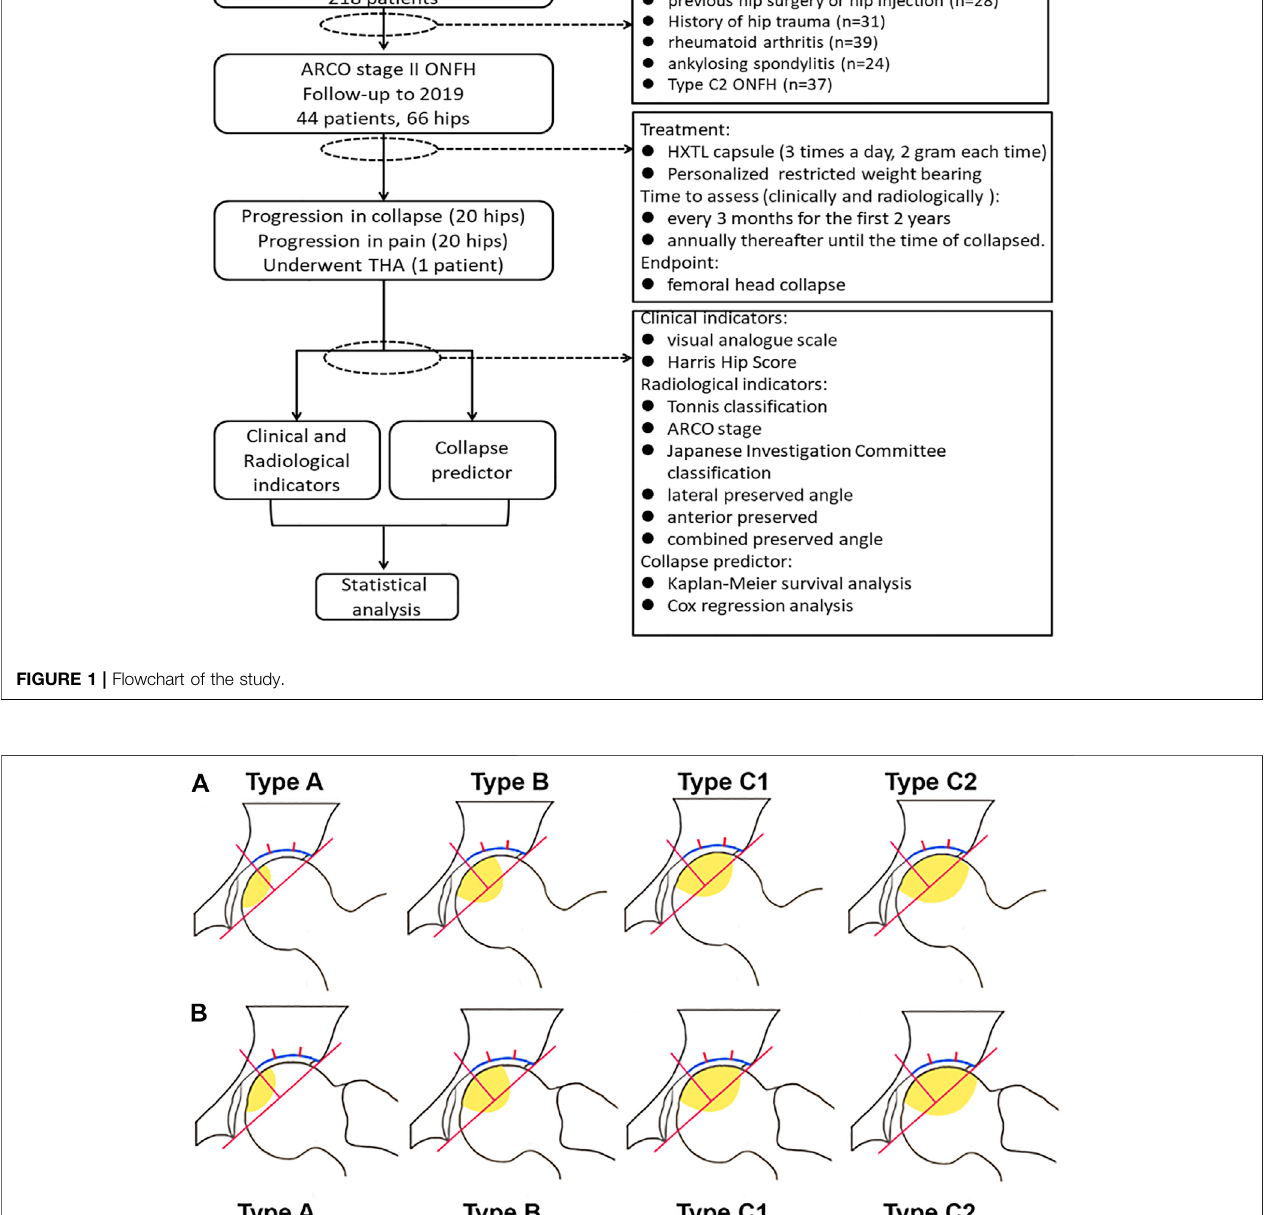
Frontiers in Pharmacology |